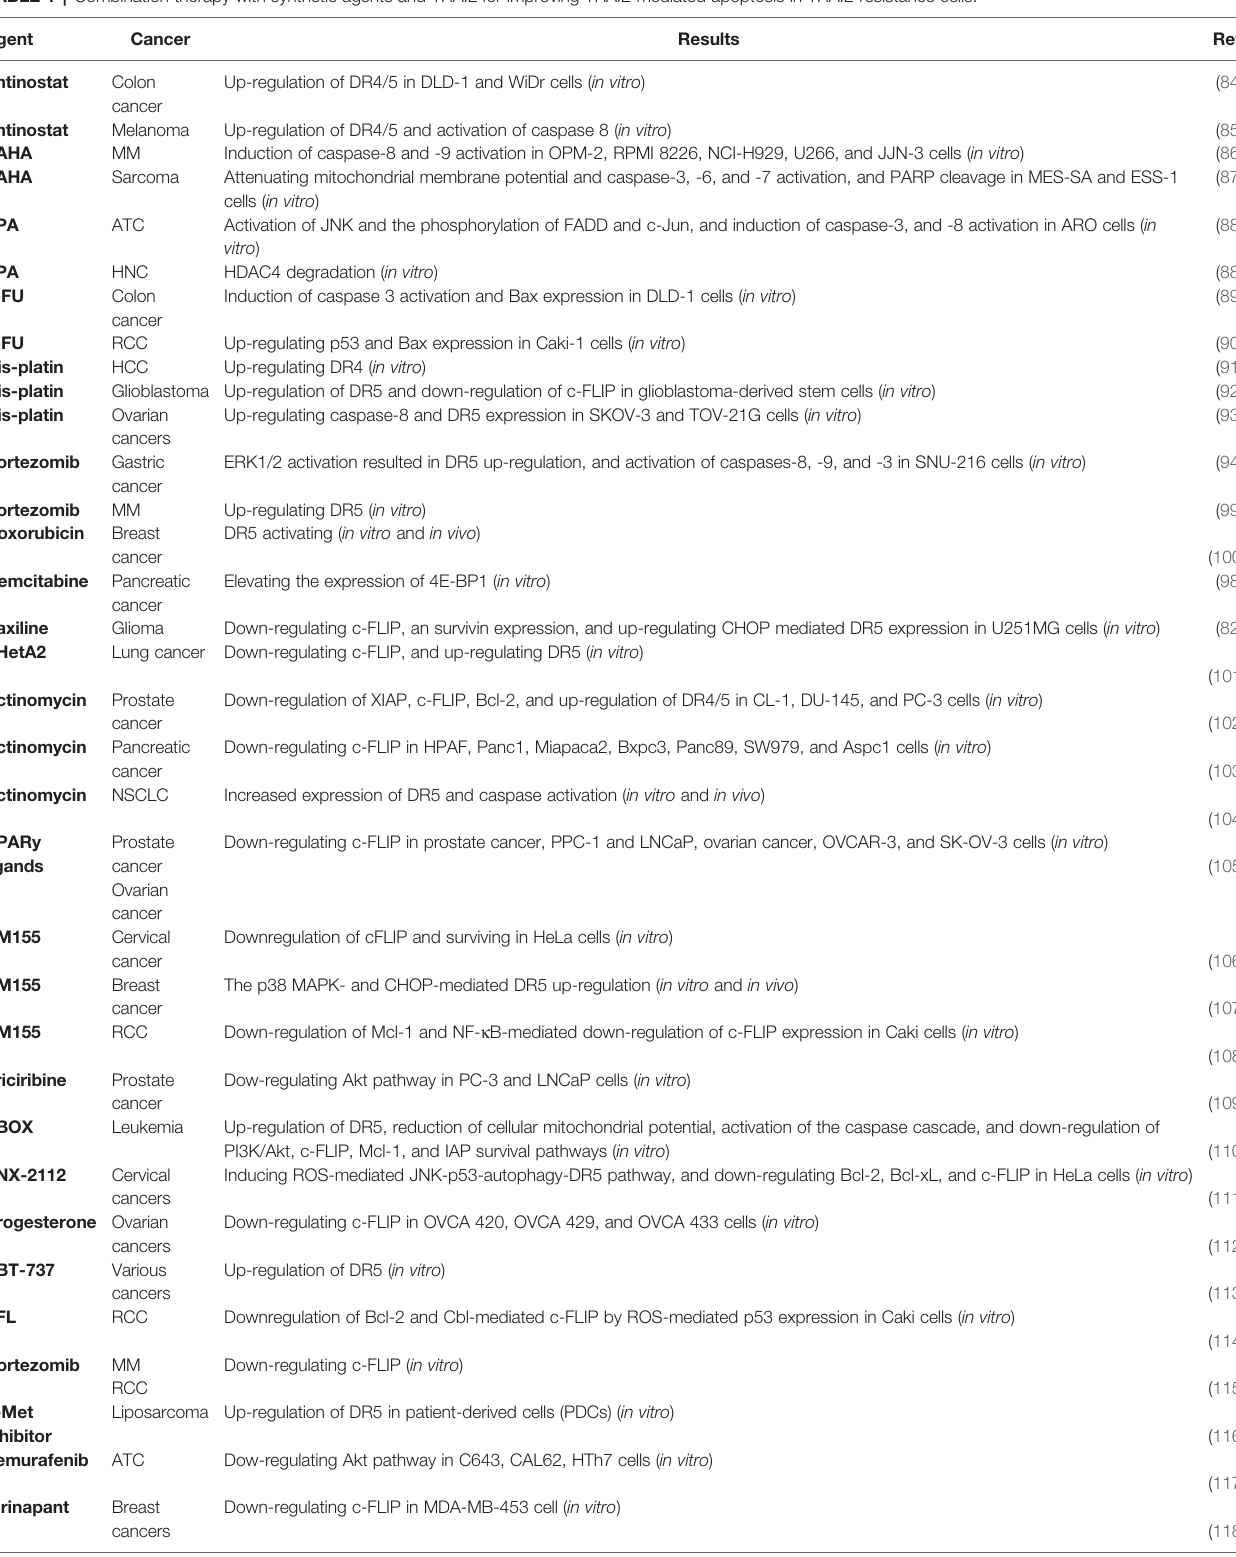
TABLE 1 | Combination therapy with synthetic agents and TRAIL for improving TRAIL-mediated apoptosis in TRAIL-resistance cells. Agent Cancer